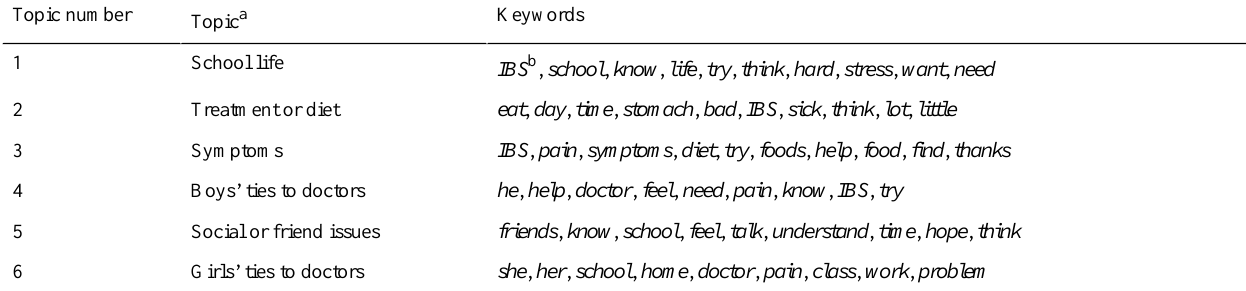
Table 2. The top 6 topics in the adolescent patients’discussion of their irritable bowel syndrome issues.